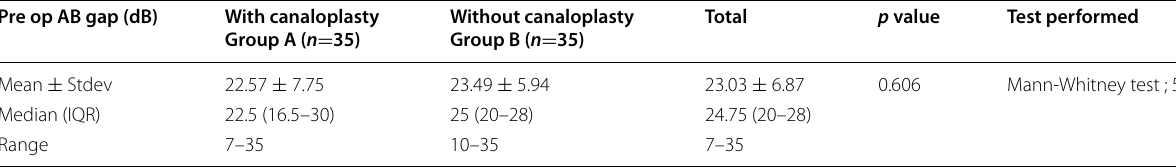
Table 2 Comparison of pre op AB gap (dB) between with and without canaloplasty Pre op AB gap (dB)